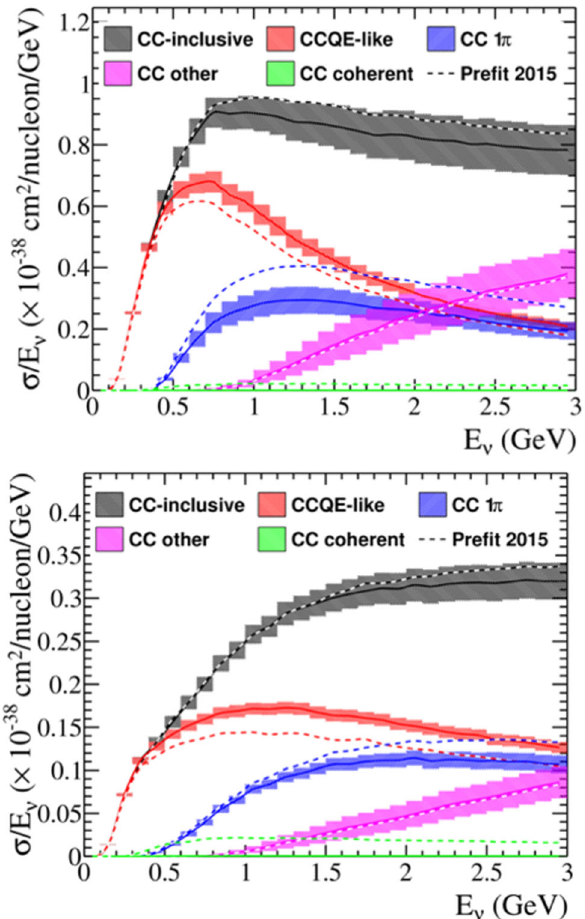
Fig. 63 Energy-dependent neutrino cross-sections divided by energy. The bands are the uncertainties of the model predictions after fitting to the ND280 data. The dashed lines are the prediction of the original model before fitting. Neutrino cross-sections (top) and anti-neutrino cross-sections (bottom) are shown